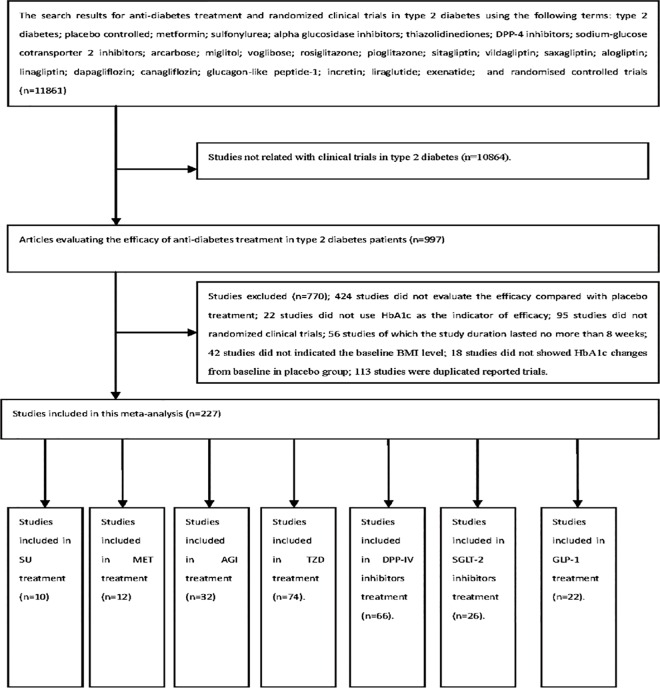
The flowchart of included studies.